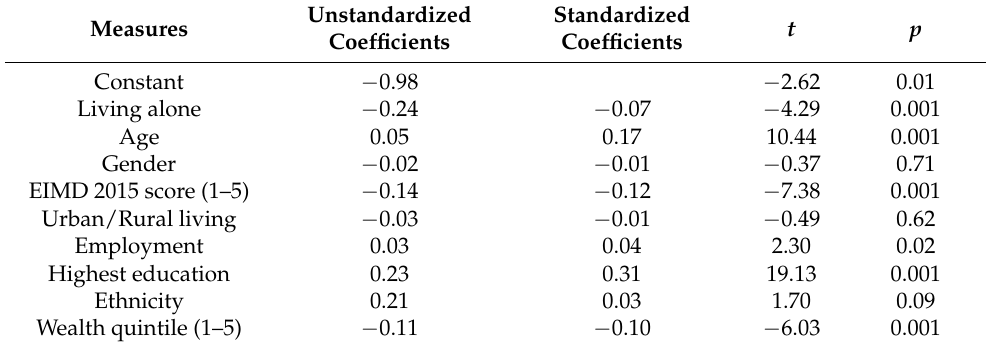
Table 2. Regression Model with Frequency of Internet Use as the Criterion